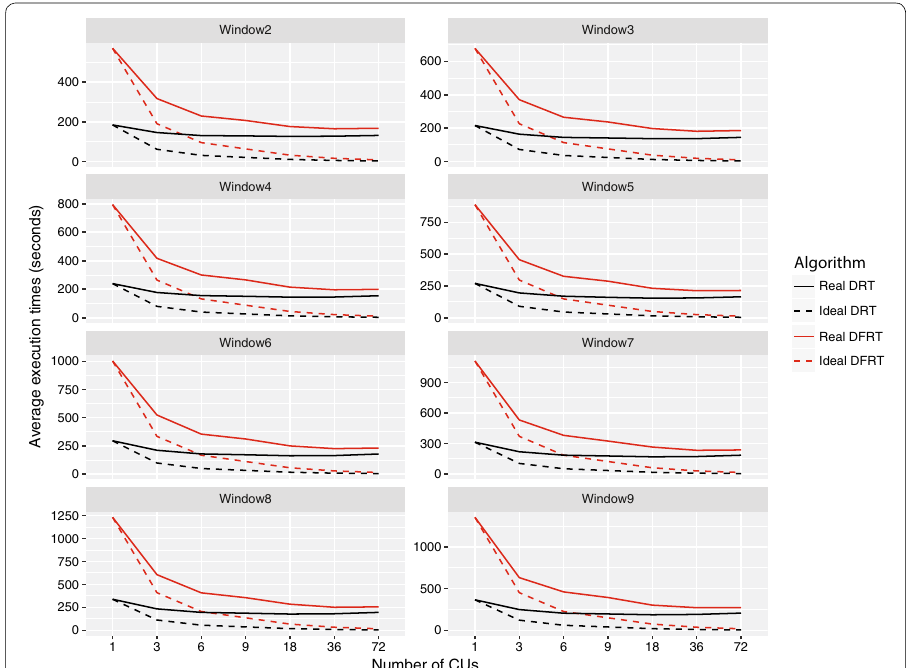
Fig. 5 Average execution times of the DRT and DFRT algorithms for the real-world datasets versus the number of CUs.